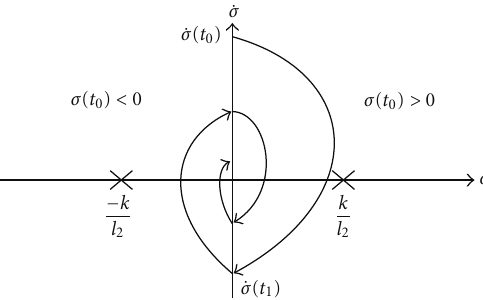
Figure 1: Phase paths of the modified second-order sliding mode